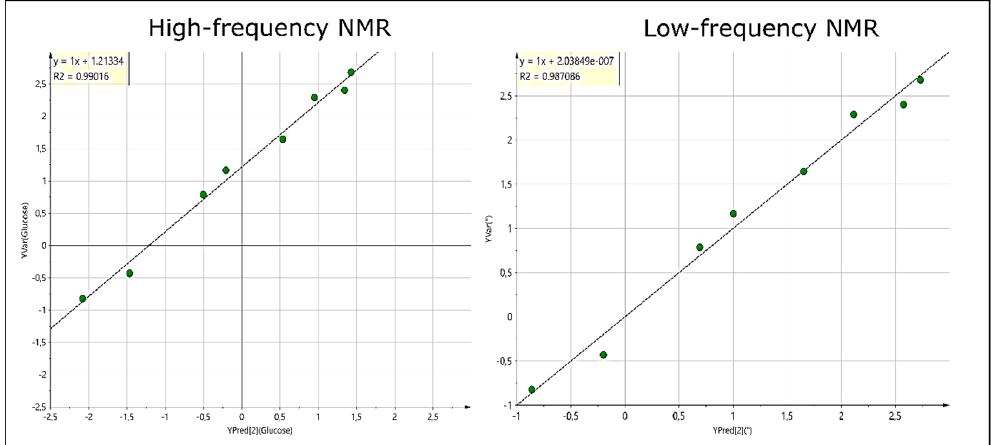
Figure 3. Transversal correlation studies between the T2D urinary metabolome and urinary glucose levels. PLS regressions were used to determine correlations between the glucose levels (Y actual values, on the y -axis) and the urinary metabolome of diabetic patients (depicted as Y predicted, on the x -axis) from spectra acquired by HF (left panel) or LF NMR analyses (right panel).